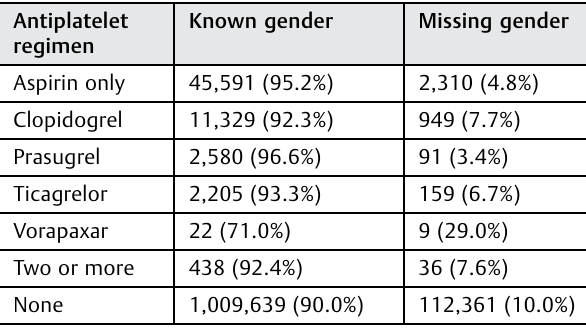
Abbreviations: FAERS, Food and Drug Administration Adverse Event Reporting System; OAA, oral antiplatelet agent.